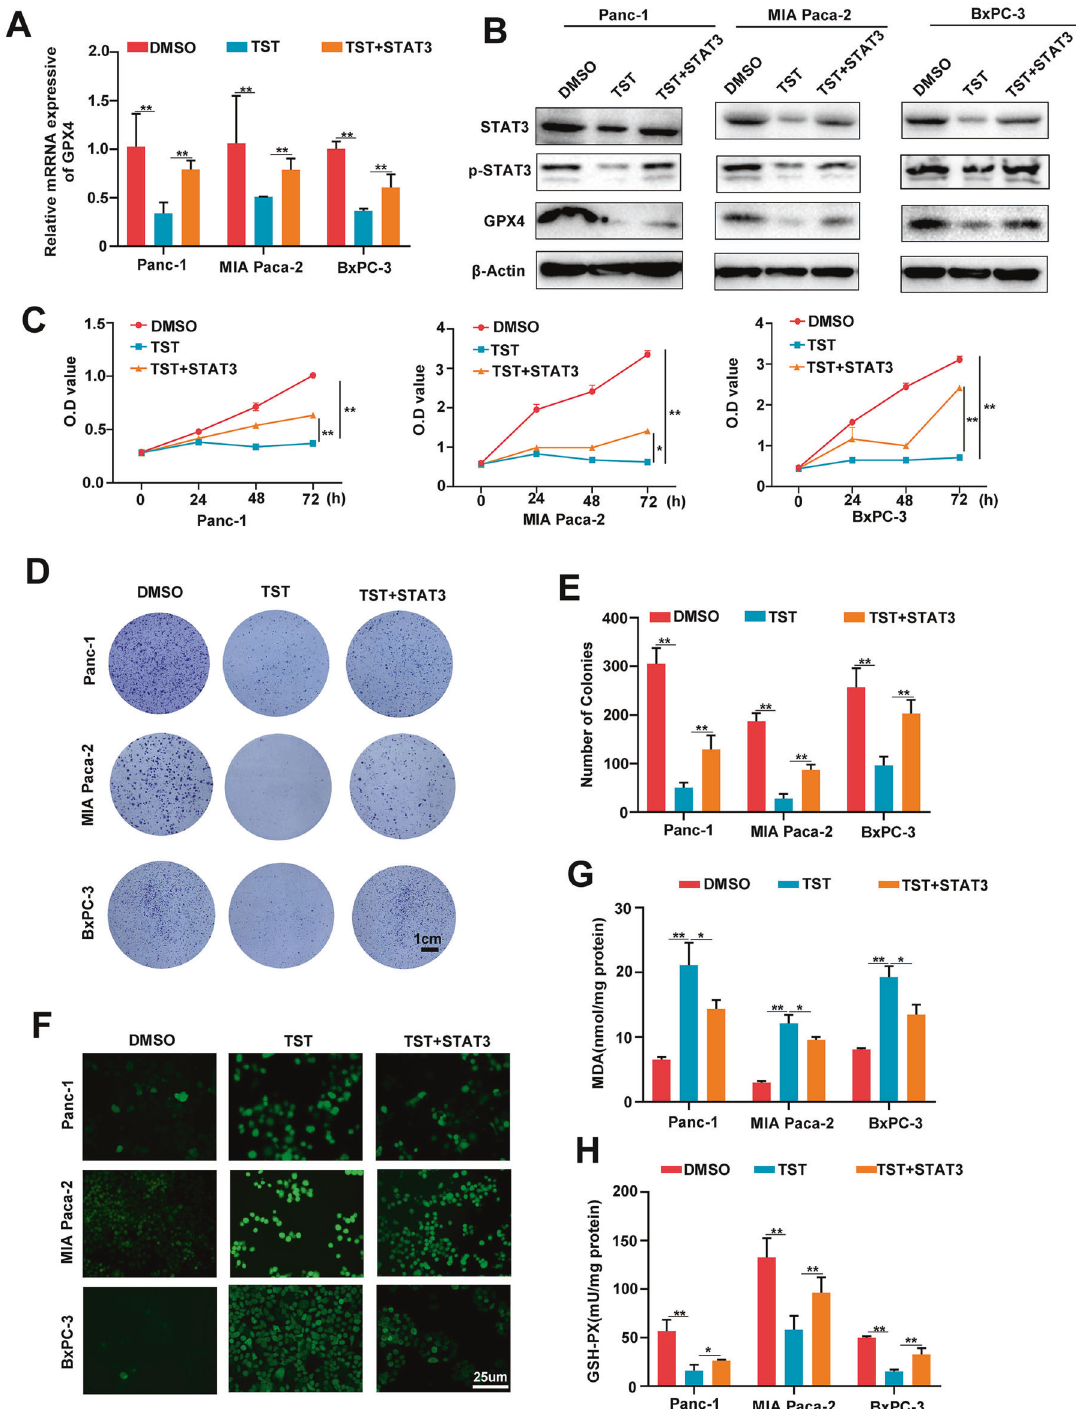
Fig. 4 Thiostrepton-induced ferroptosis depends on the STAT3 – GPX4 signalling pathway. A qRT – PCR analysis of GPX4 mRNA expression. B Western blotting analysis of STAT3, p-STAT3 and GPX4 levels in Panc-1, MIA PaCa-2, and BxPC-3 cells receiving different treatments (DMSO, TST, and TST + STAT3). C OD value of the CCK-8 assay was conducted at 0, 24, 48, and 72 h using pancreatic cancer cells from different treatment groups. D and E Clone formation ability and number of pancreatic cancer cells receiving different treatments. F , G , H ROS, MDA and GSH-PX levels were detected in Panc-1, MIA PaCa-2, and BxPC-3 cells from the different treatment groups (* P < 0.05 and ** P < 0.01). Thiostrepton-induced ferroptosis depends on the values, we found that STAT3 overexpression increased WT2 GPX4 STAT3 – GPX4 signalling pathway promoter reporter activity but not MUT2 activity (Fig. 3K). Given that TST-induced ferroptosis activated the STAT3 – GPX4 Collectively, these data suggest that TST alters GPX4 transcription signalling pathway in pancreatic cancer cells, we assumed that by decreasing STAT3 expression. Cell Death and Disease (2022)